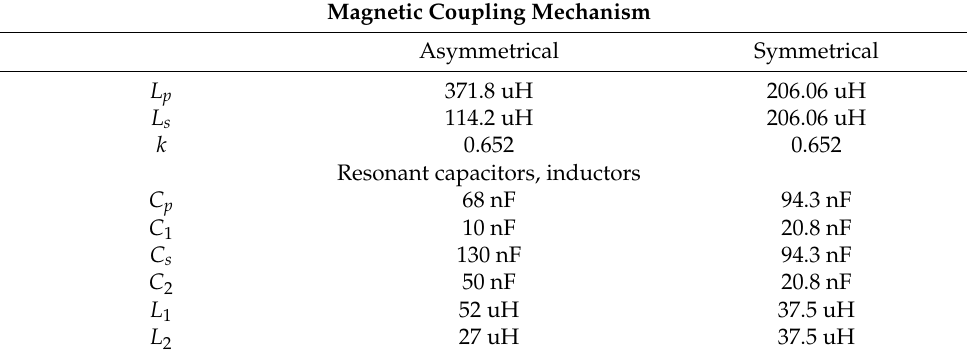
Table 2. Wireless power transfer system parameters.